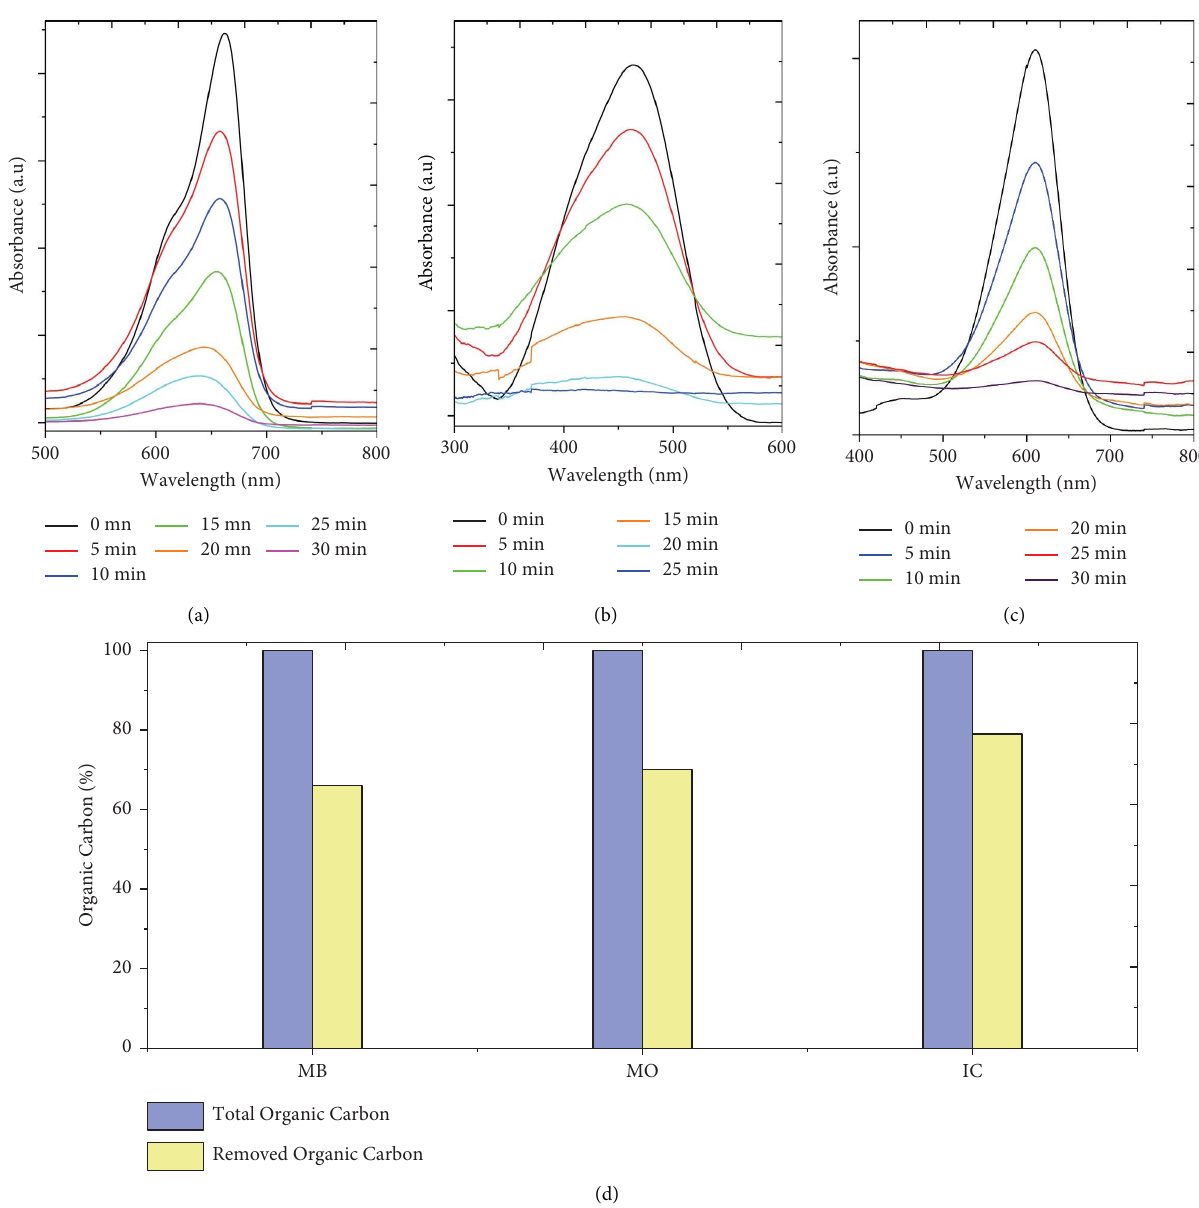
Figure 10: (a) MB, (b) MO, (c) IC degradation by PU-Fe 2 O 3 membrane after, (d) organic carbon removable after 150min (TOC